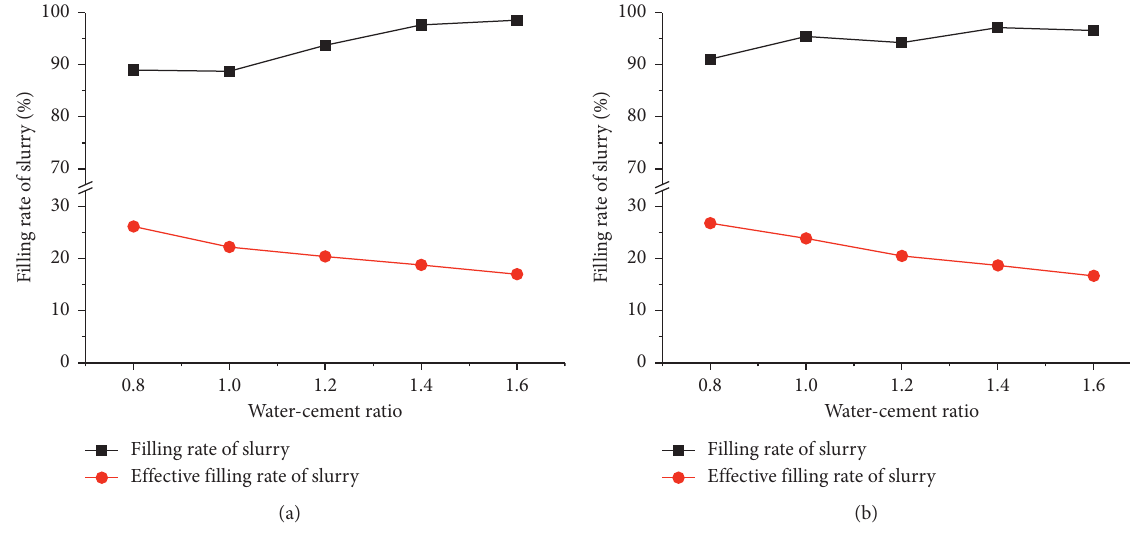
Figure 8: Variation of filling rate of slurry with water-cement ratio. (a) d � 0.63–2.5mm. (b) d �